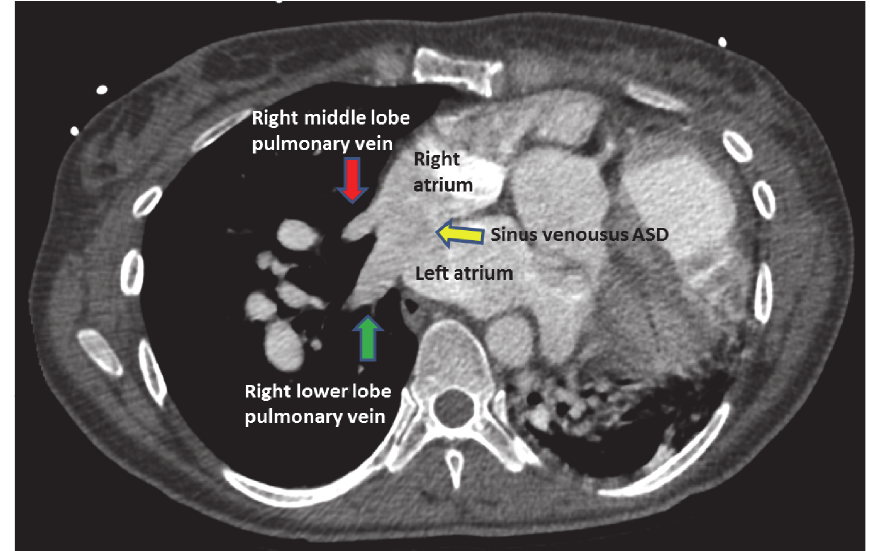
Figure 3: Computed tomographic angiography of the chest shows the right middle lobe vein (red arrow) draining into the right atrium (partial anomalous pulmonary venous return) and the right lower lobe vein (green arrow) entering the heart at the junction of the right and the left atria at the level of a large atrial septal defect (yellow